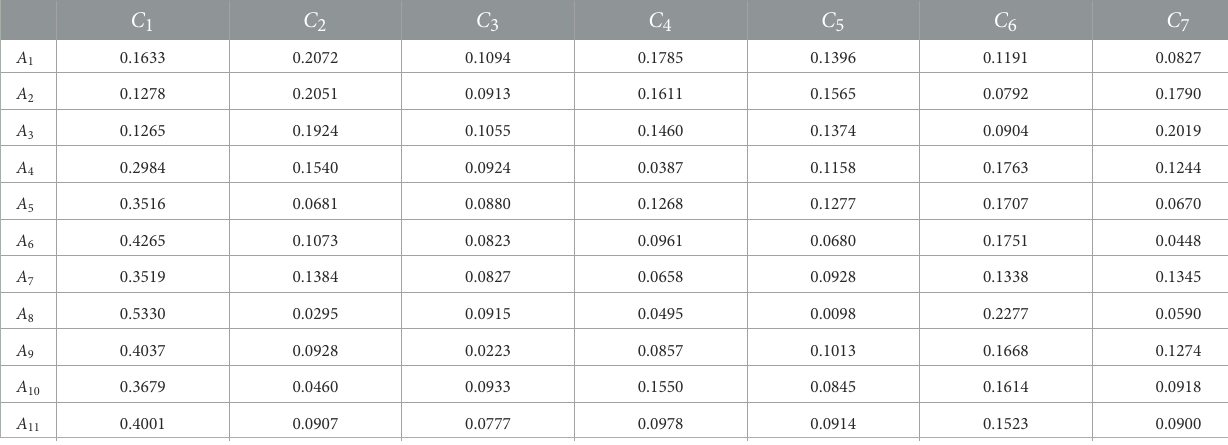
TABLE 5 The relative closeness of